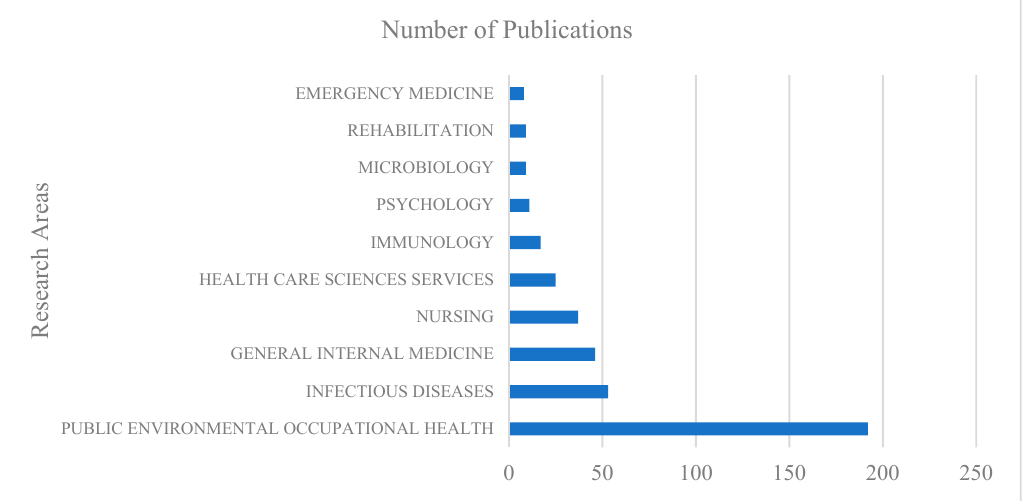
Table 1. Top ten countries with the largest number of